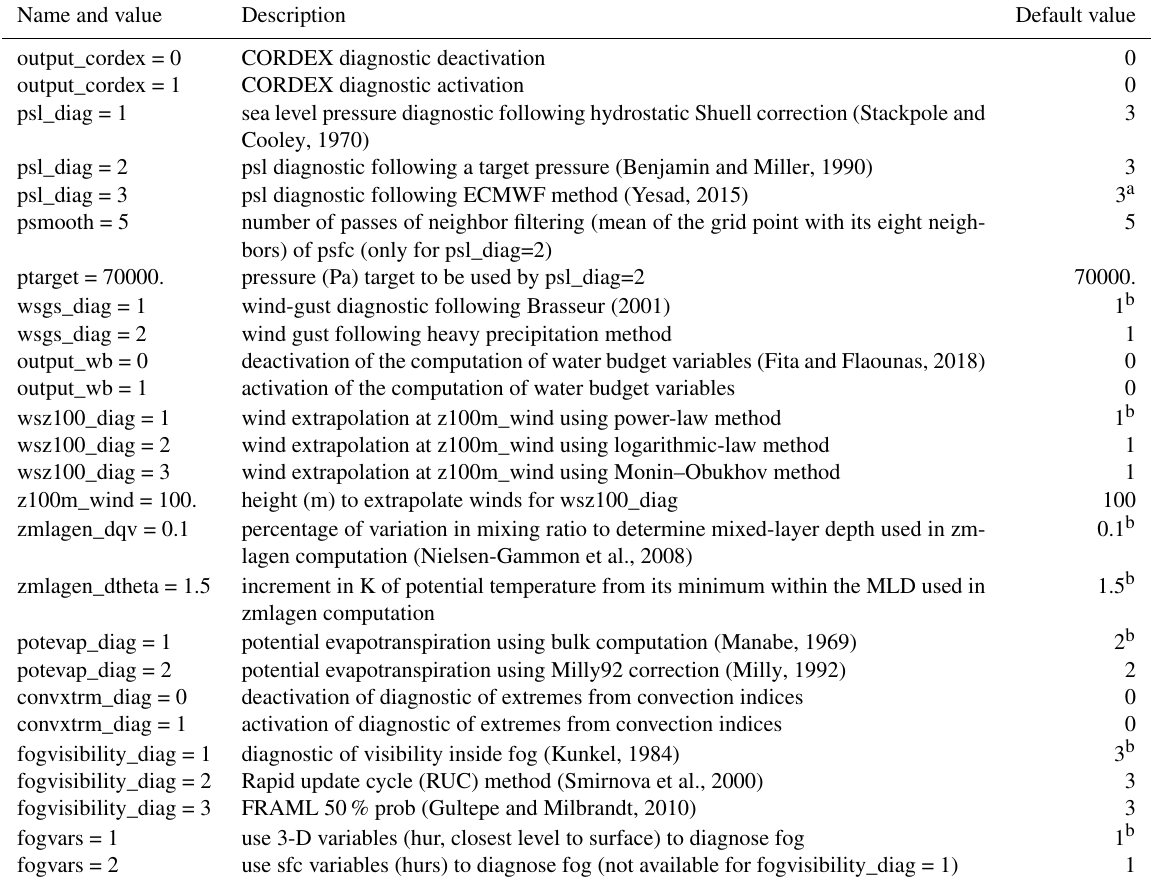
Table 1. Setup parameters of the module_diag_cordex module for the WRF namelist contained in the cordex section. See the sections on variables for more details on the meaning of each methodology. The methodologies preferred by CORDEX are marked by a , and the ones without preference by CORDEX are marked by b ; in these cases, users can select the method according to their